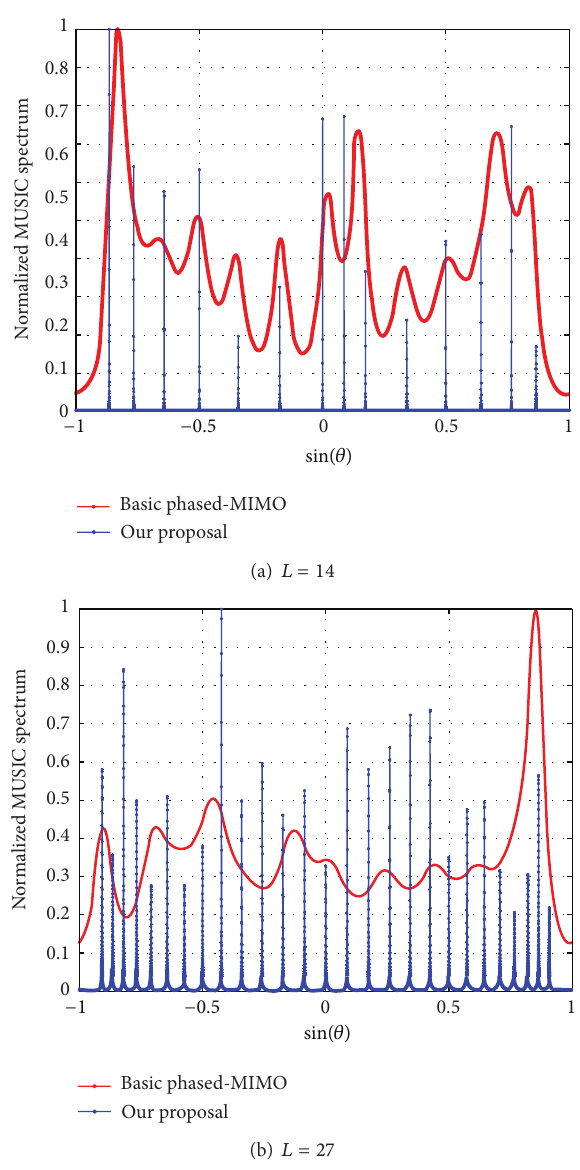
Figure 6: DOF comparisons in MUSIC